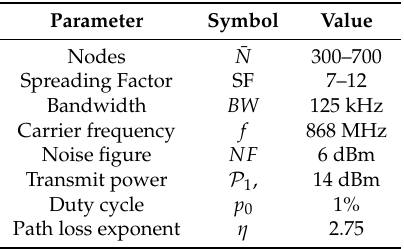
Table 3. System Parameters.